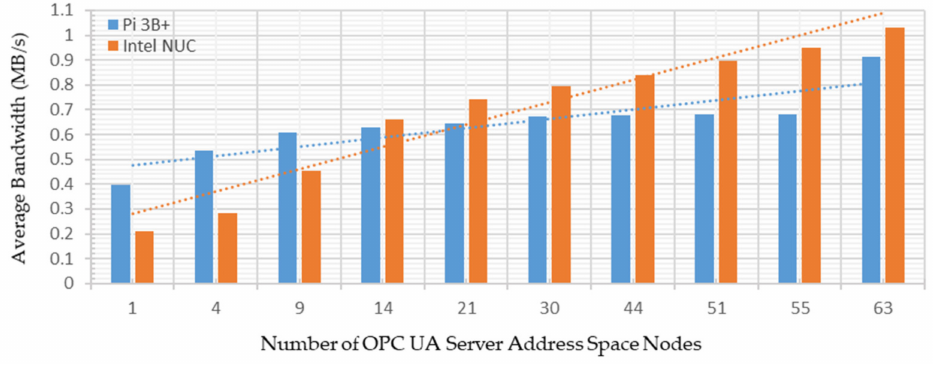
Figure 17. Average bandwidth utilization with varying the OPC UA server address space nodes. From Figure 17, averages of 0.2121 MB/s and 0.3991 MB/s bandwidth were utilized to